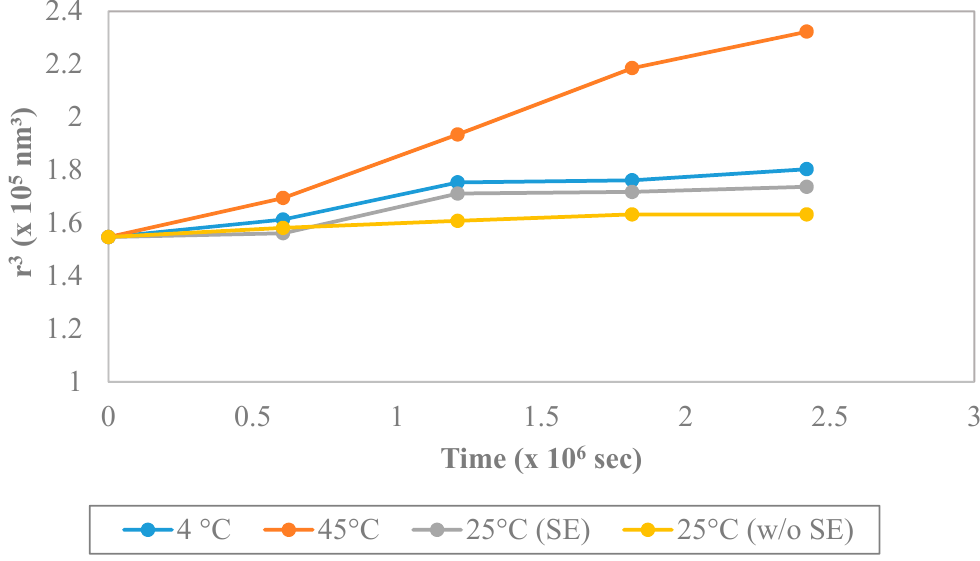
Figure 7. Graph of r 3 vs. storage time (seconds).